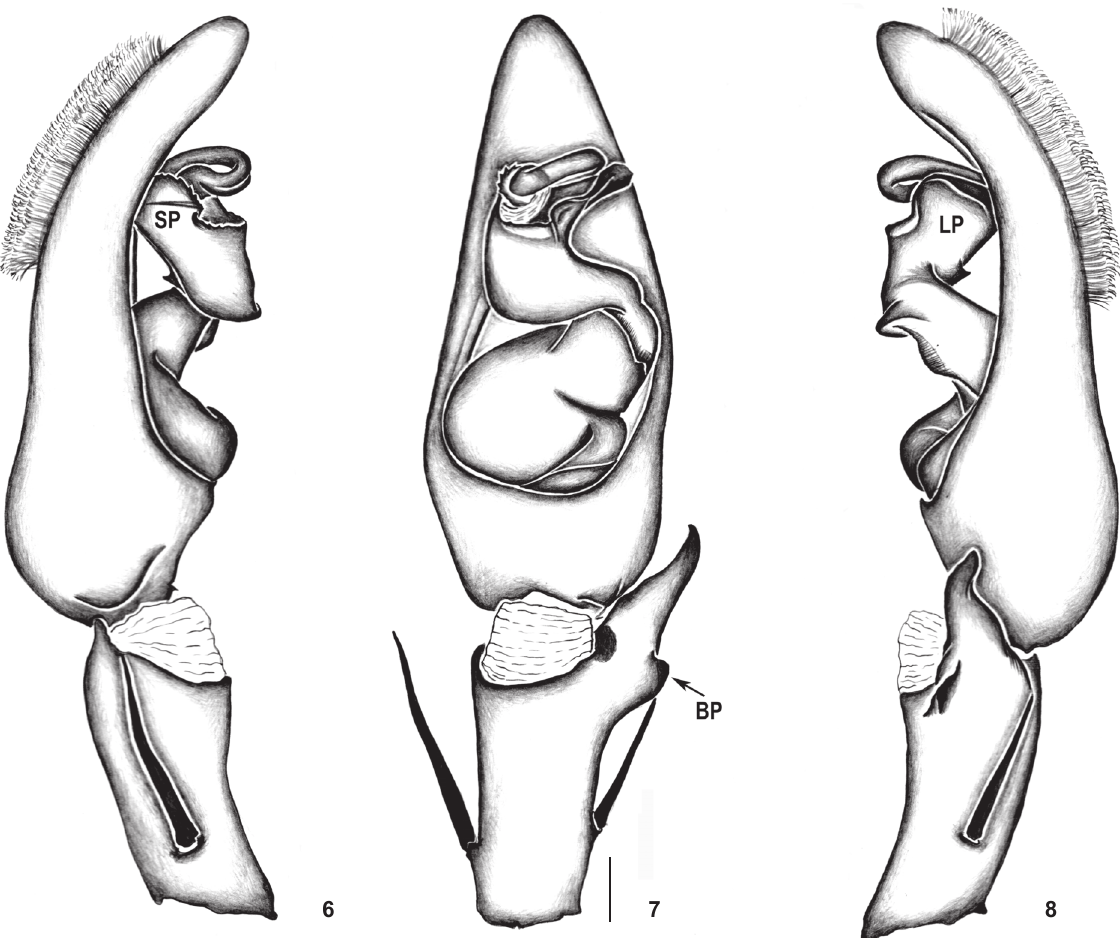
Figures 6-8. Macrinus calypso sp.nov. : (3) male, left palp, prolateral view; (4) ditto, ventral view; (5) ditto, retrolateral view. (BP) Basal process of RTA, (LP) laminar projection, (SP) serrated projection. Scale line = 0.5